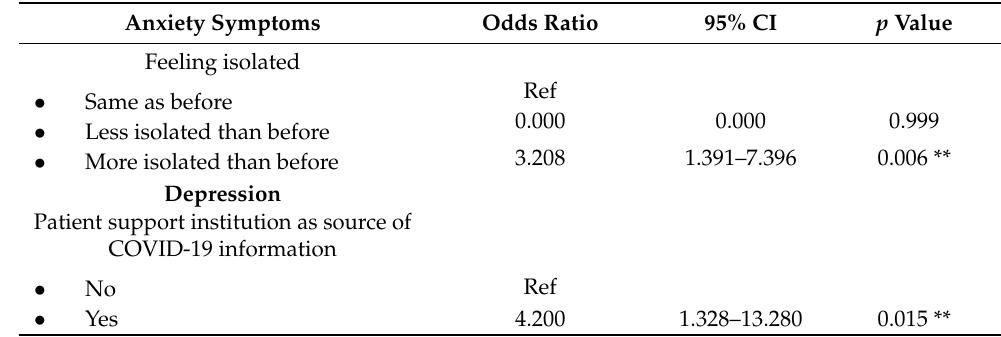
Table 5. Regression analysis to determine the factors independently associated with anxiety symp- toms and depression ( n =